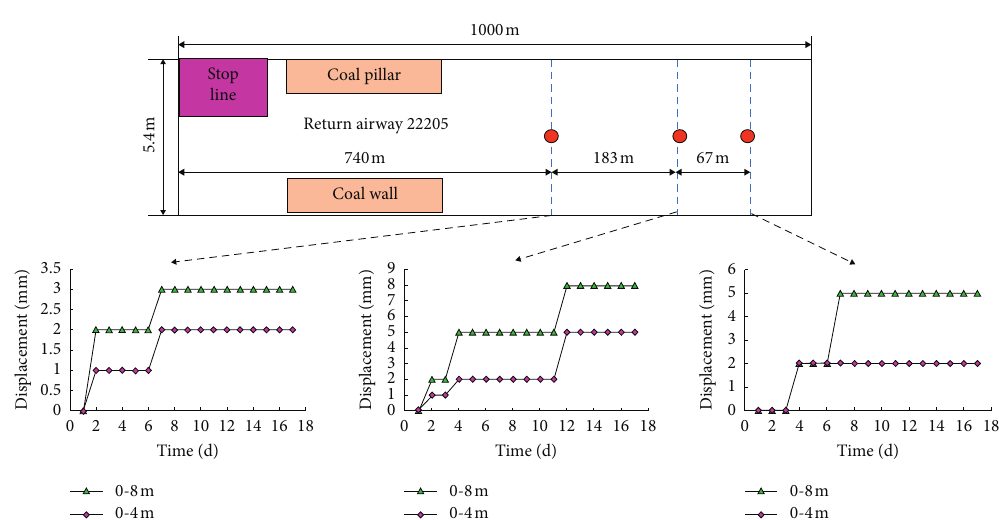
Figure 17: Multipoint displacement curve after reinforcement